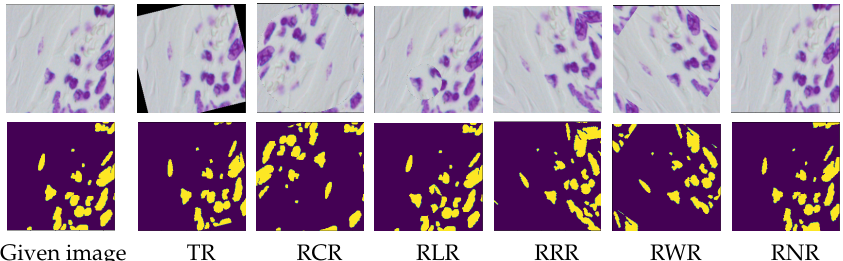
Figure 18. Samples of the Nuclei images dataset by applying the RLR, TR, RCR, RRR, RWR and RNR augmentation techniques. Rows one and two are the augmented samples with their corresponding segmentation,